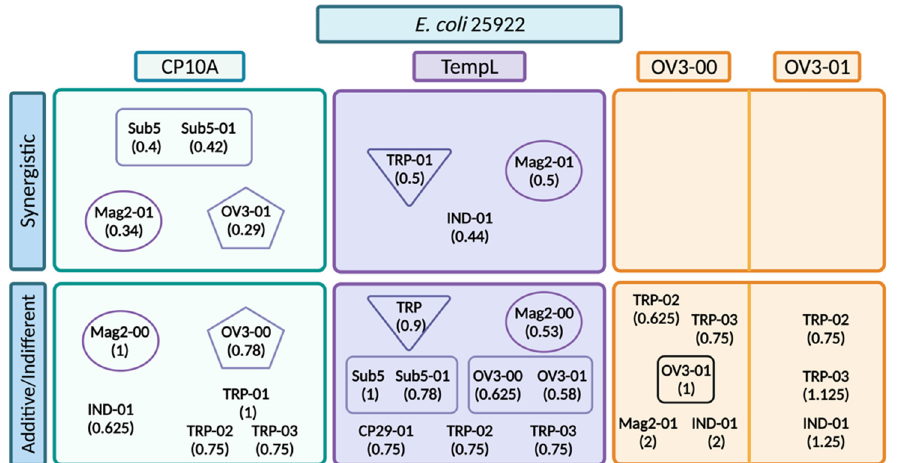
Figure 6. Summary of peptide interactions in E. coli 25922 from data presented in Results and Supplemental Material. Synergistic (or non-synergistic) interactions for CP10A, TempL, OV3-00 and OV3-01 with other peptides are grouped as shown. Parental and ATCUN derivatives are outlined in the same shape with the average FIC value shown in parentheses.